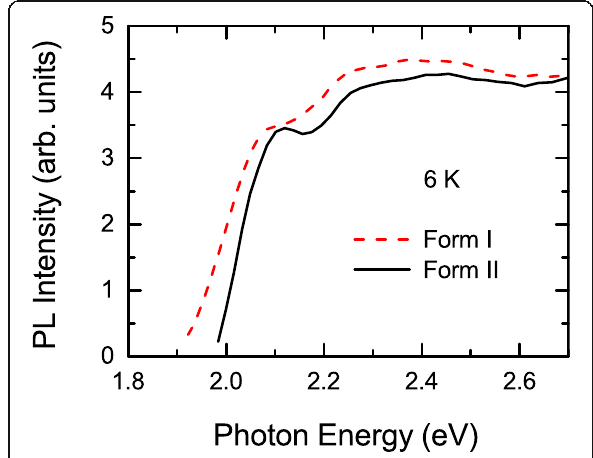
Fig. 4 Excitation spectra of spin-coated and drop-cast thin films measured at 6